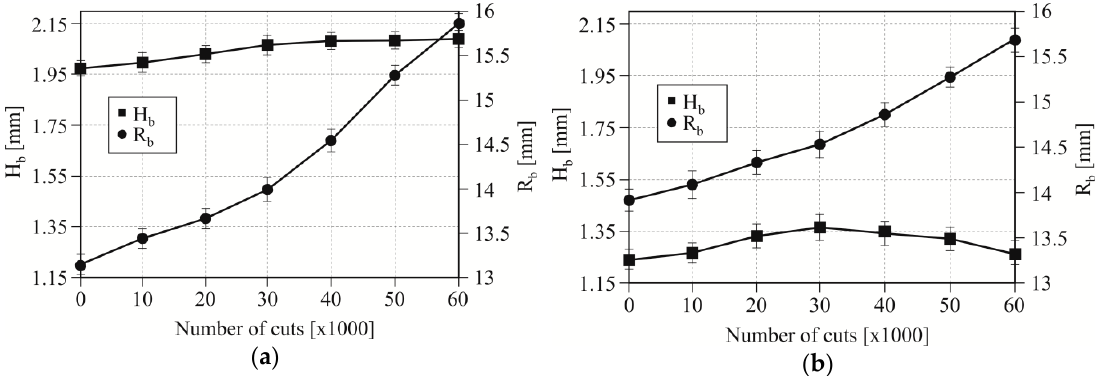
Figure 10. The influence of changes in H b and R b values depending on the number of cuts; for blanking clearance: ( a ) 5% and ( b ) 15%.